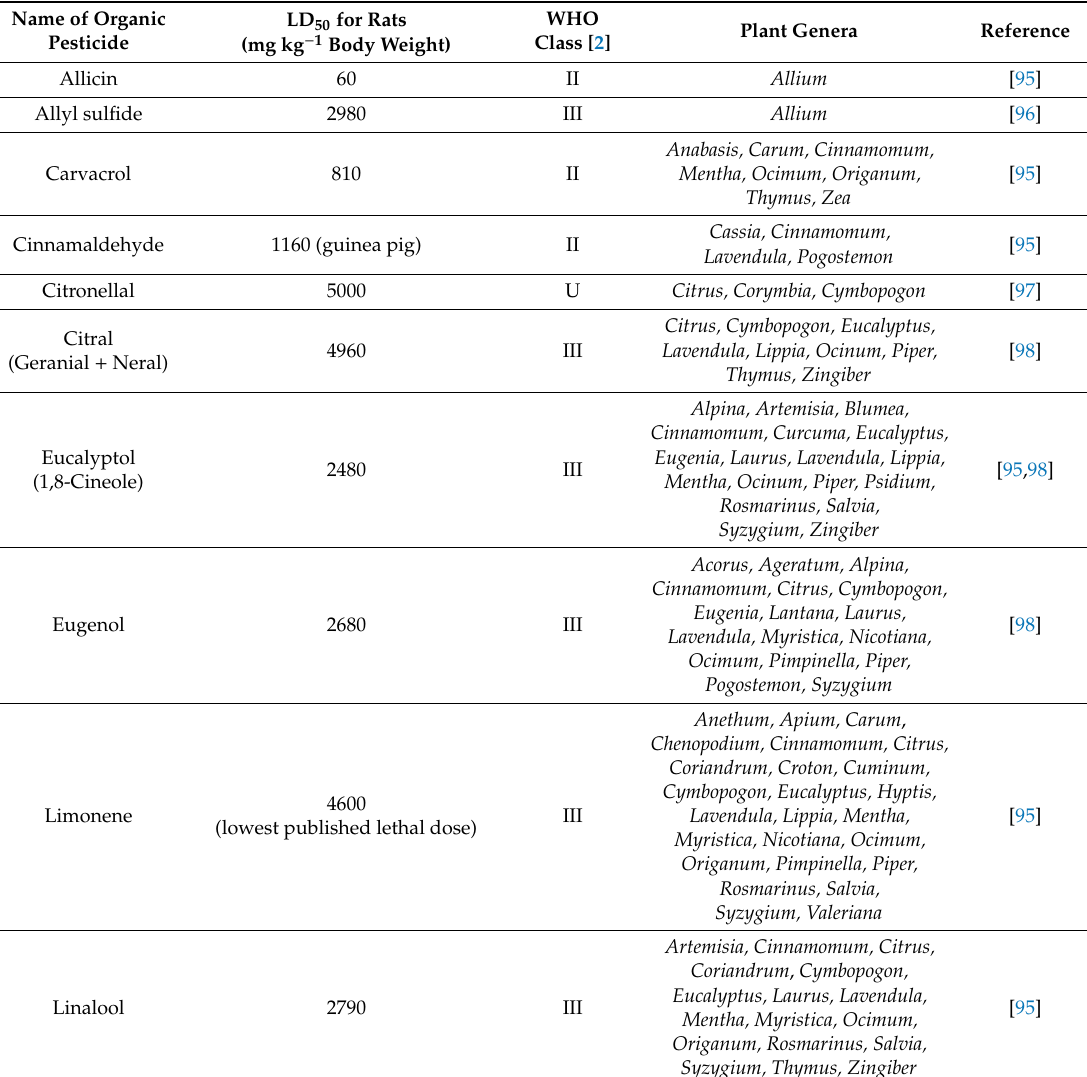
Table 2. Some typical compounds extracted from plants used as